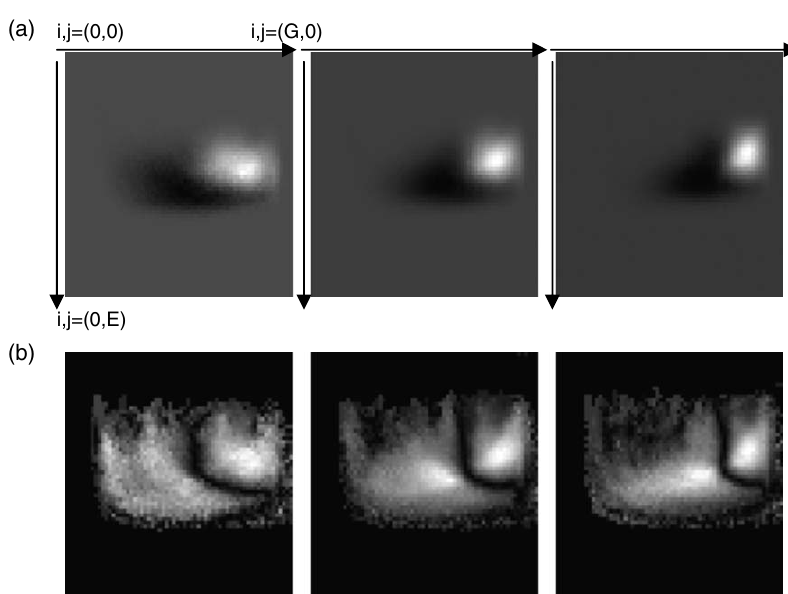
Fig. 1. (a) Gray level entropy matrix (GLEM) class difference matrices (cid:2) P (i , j | a ,ω 1 ,ω 2 ) between the two prognostic classes of early ovarian cancer, computed from the learning set nuclear images within area groups a=2–4. For each gray-scale plot, areas that are lighter (darker) than the background correspond to GLEM matrix elements that contain a higher (lower) probability for the good prognosis class compared to the poor prognosis class. (b) GLEM Mahalanobis class distance matrices J P (i , j | a ,ω 1 ,ω 2